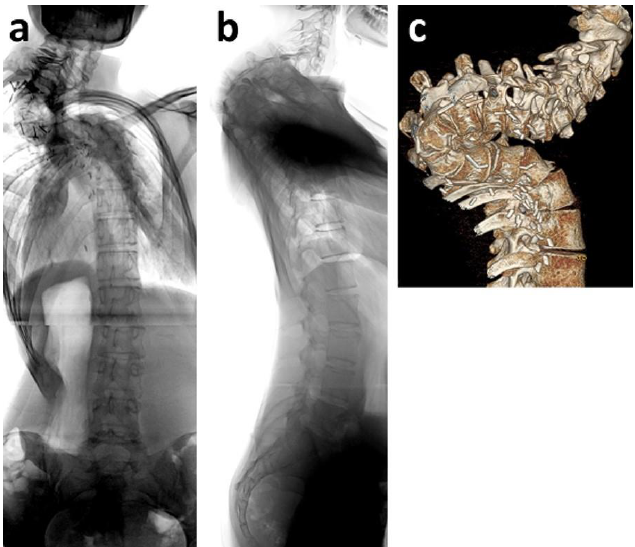
Figure 5. Fifteen-year old girl with juxta-spinal neurofibromatosis and severe three-dimensional upper thoracic spinal deformity ( a – c ). MRI prior to surgical treatment revealed severe neurofibromatosis with thoracic obstruction, which was incompletely